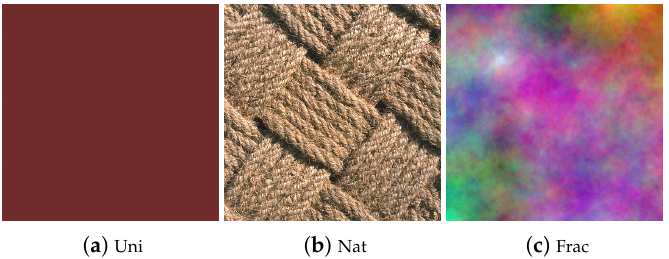
Figure 1. Stimuli images examples: one color image ( Uni ), natural color texture ( Nat ) image (VisTex) and synthetic color fractal texture image ( Frac